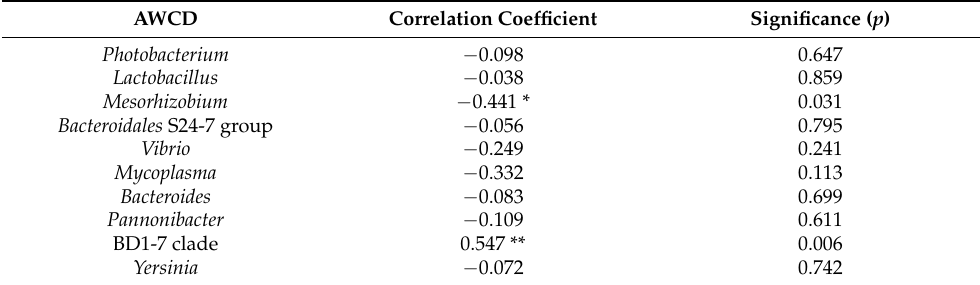
Table 4. Correlation analysis between the AWCD and the relative abundance of dominant intestinal bacteria at the genus level.